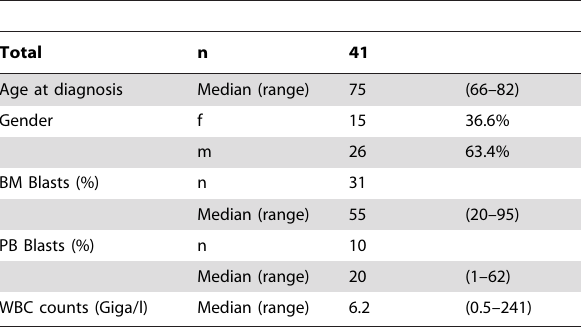
Table 2. Characteristics of AML patients analyzed by pyrosequencing.